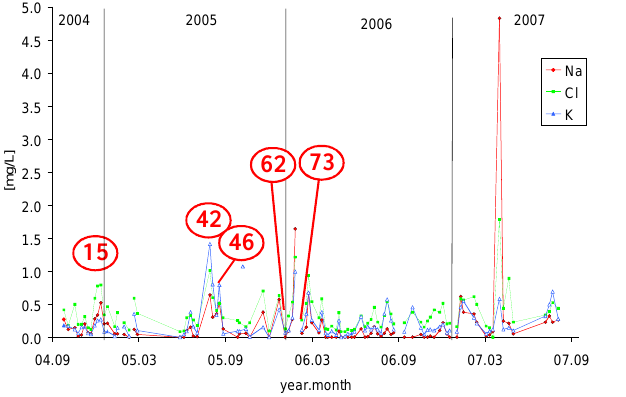
Figure 4: Fig. 4. Same as in Fig. 3, but for Na, Cl, and K.